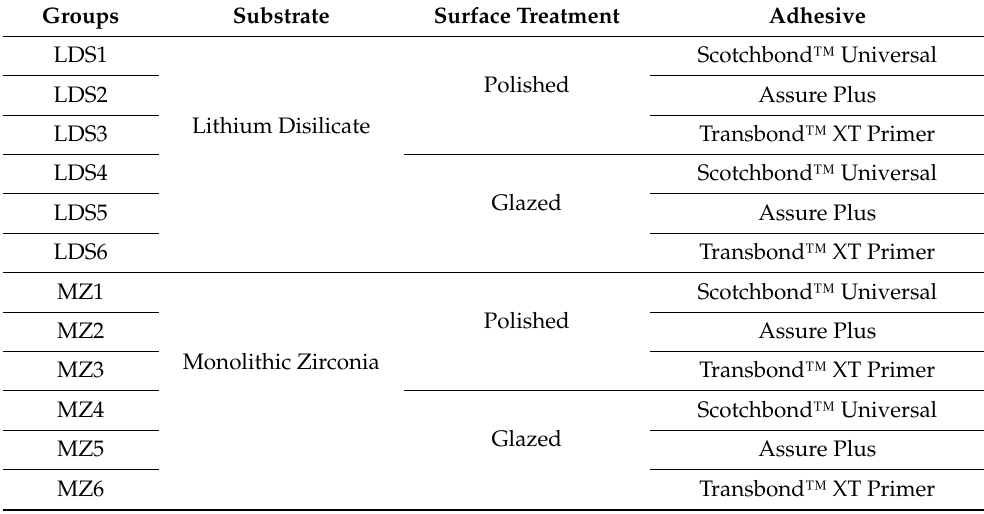
Table 2. Experimental groups.